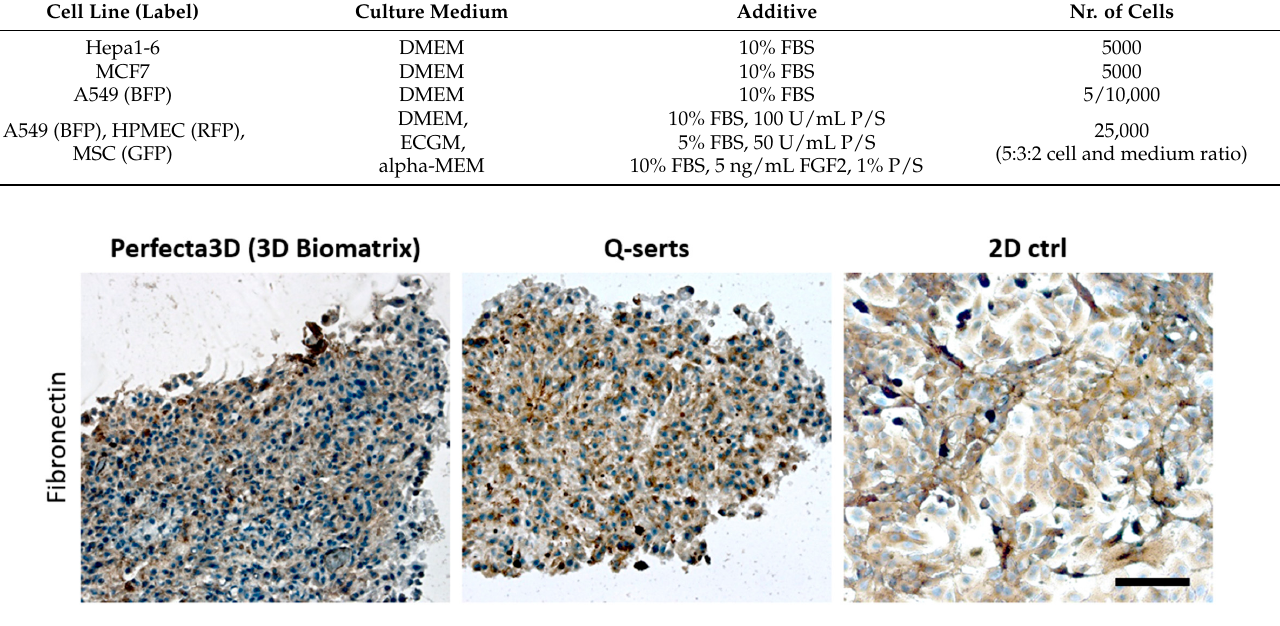
Figure 6. Immunohistochemical staining for fibronectin expressed in STEM spheroids grown in different hanging drop formats. 2D triculture served as positive control . Areas of fibronectin is denoted by brown stained regions. Hematoxylin counterstain was used for cell nuclei (blue). Scale bar 100 µm.